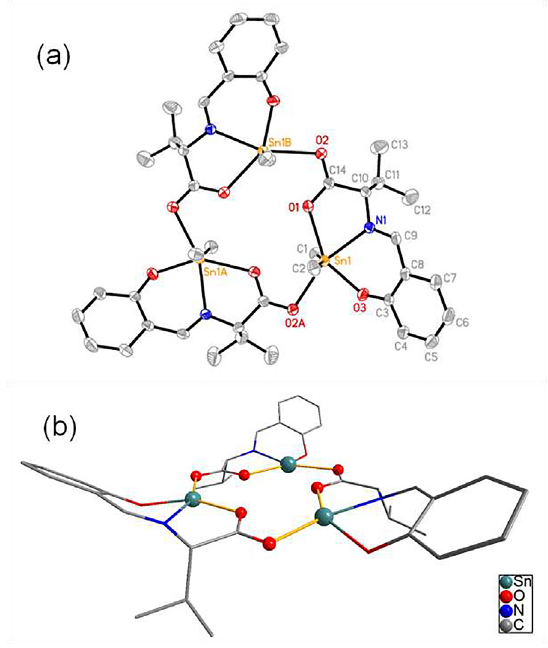
Figure 1: The molecular structure of 1 . (a) Ellipsoid diagram (30% probability); (b) ball and stick diagram (methyls bound to tin are omitted for